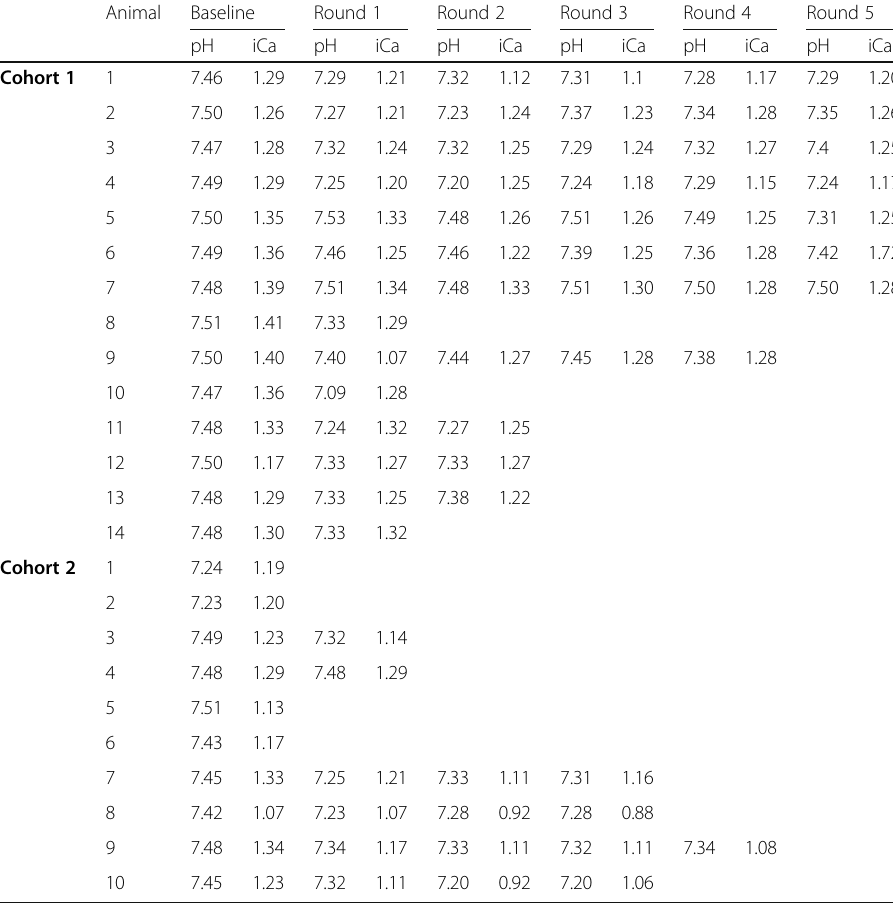
Table 1 Results of cohorts 1 and 2 of animal